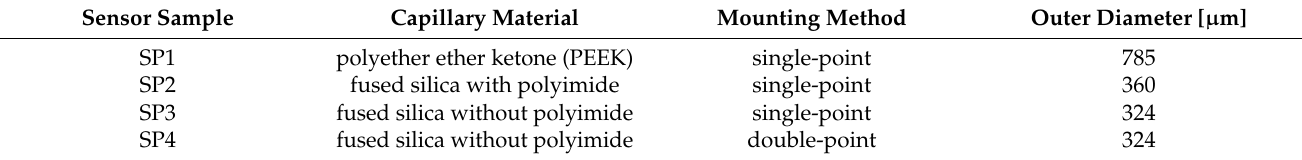
Table 1. The sensor sample, the material, the mounting method, and the diameter of the encapsulation. Single-point: the capillary is glued to the fiber on one point only; the other side is sealed before mounting. Double-point: the capillary is glued to the fiber on both sides of the capillary.